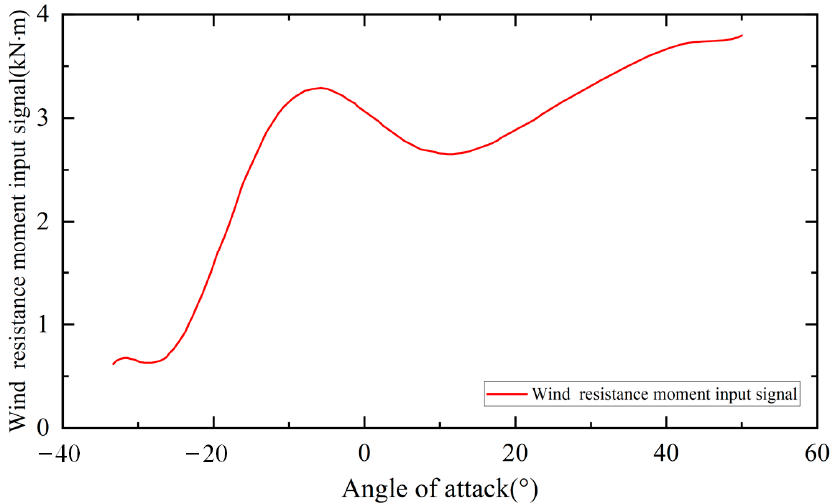
Figure 9. Wind resistance moment input signal.